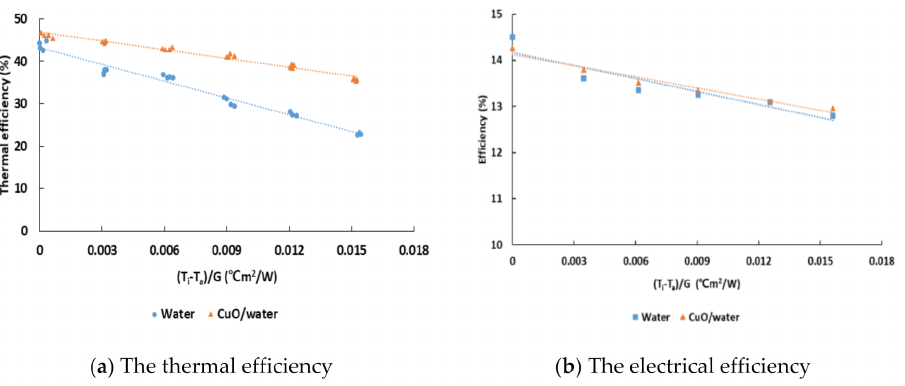
Figure 4. The efficiency of the PVT system using water and CuO-water nanofluid according to